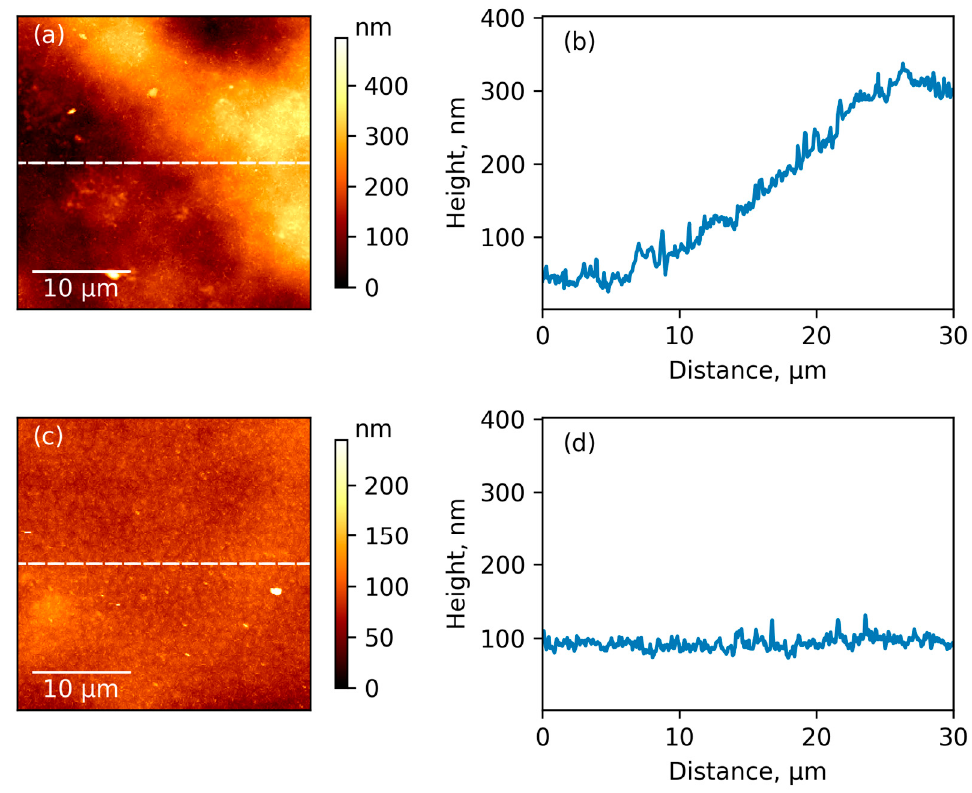
Figure 6. Surface topography of upper side of R-BAPB film ( a ), composite film with zirconia ( c ), and profile curves ( b , d ).